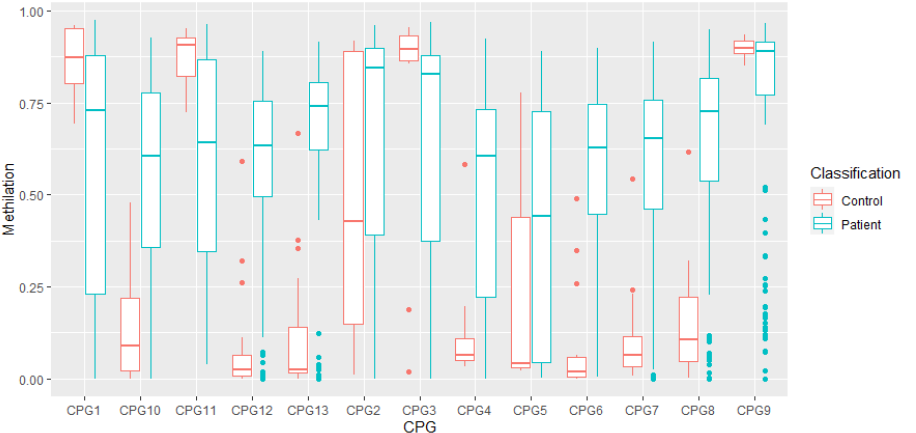
Figure 4. Mean methylation values for patients and control cases.